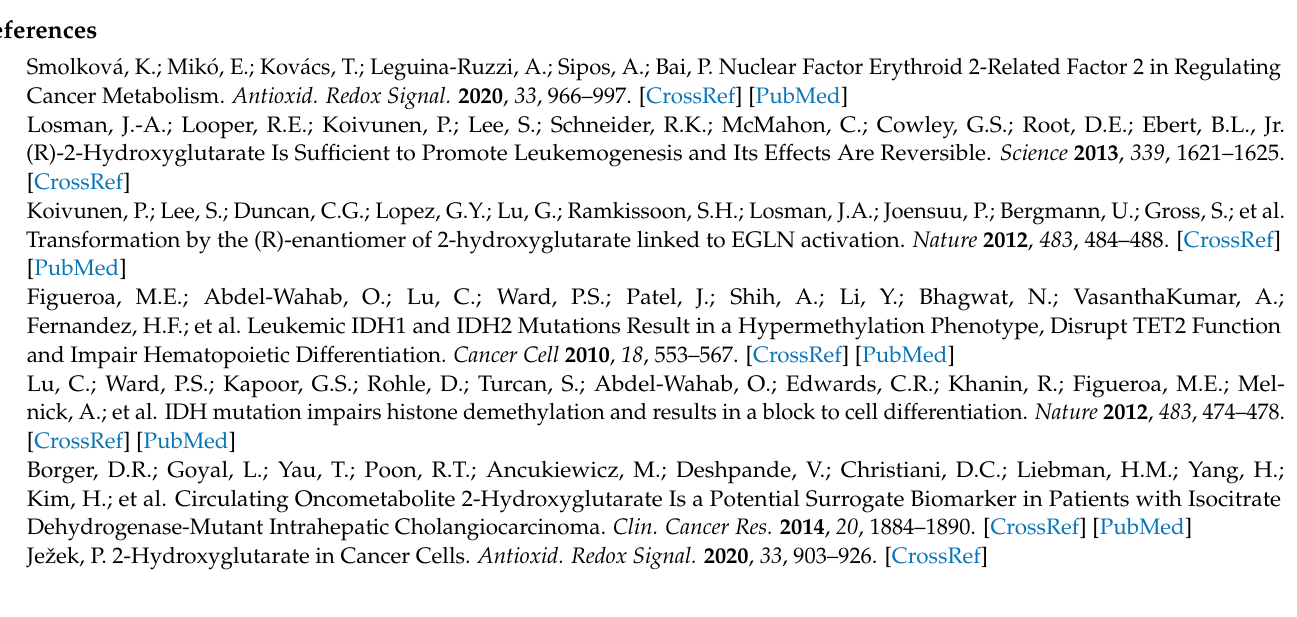
graphs to Figure 2. Figure S3: Supplemental graphs to Figure 3. Figure S4: Supplemental graphs to Figure. Table S1: Cut-off values derived from the corresponding ROC curves. Table S2: Stratification of patients. Table S3: List of primer sequences used for qPCR analysis in the study. Figure S5: Supplemental graphs to Figure 5. Figure S6: Creatinine values in the urine samples of breast carcinoma patients. Figure S7: Full-length western blots presented in the